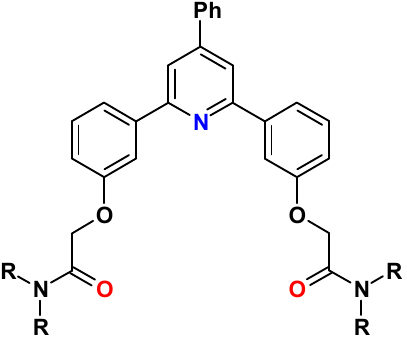
Figure 12. Tri-aryl-pyridine diamides.